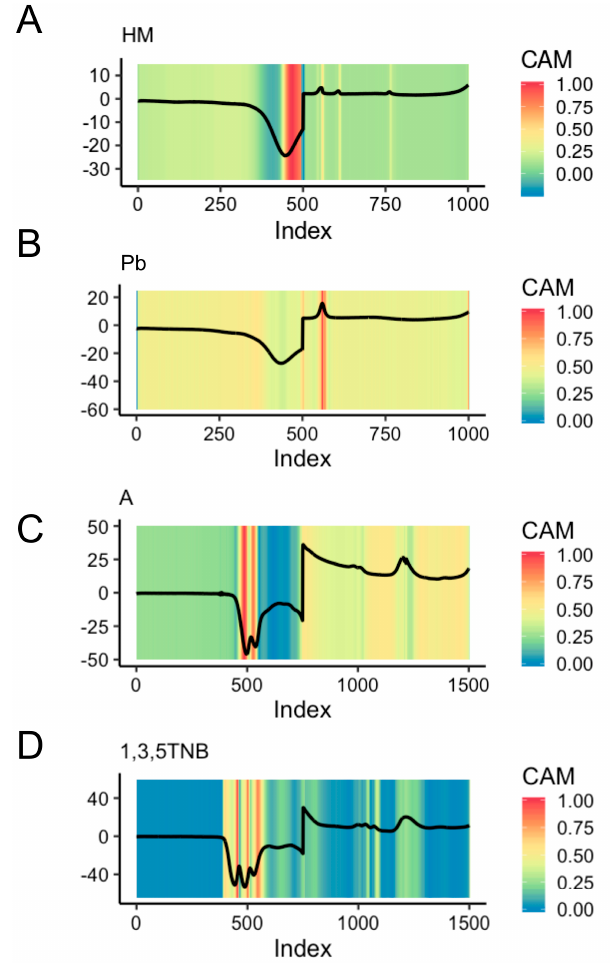
Figure 4. Information that fully convolutional network (FCN)-containing models provide. ( A ) Class activation map (CAM) for 4-SW. Representative HM sample is shown. ( B ) CAM for 11-SW. Representative Pb sample is shown. ( C ) CAM for 3-EXP. Representative A sample is shown. ( D ) CAM for 11-EXP. The representative 1,3,5-TNB sample is shown.